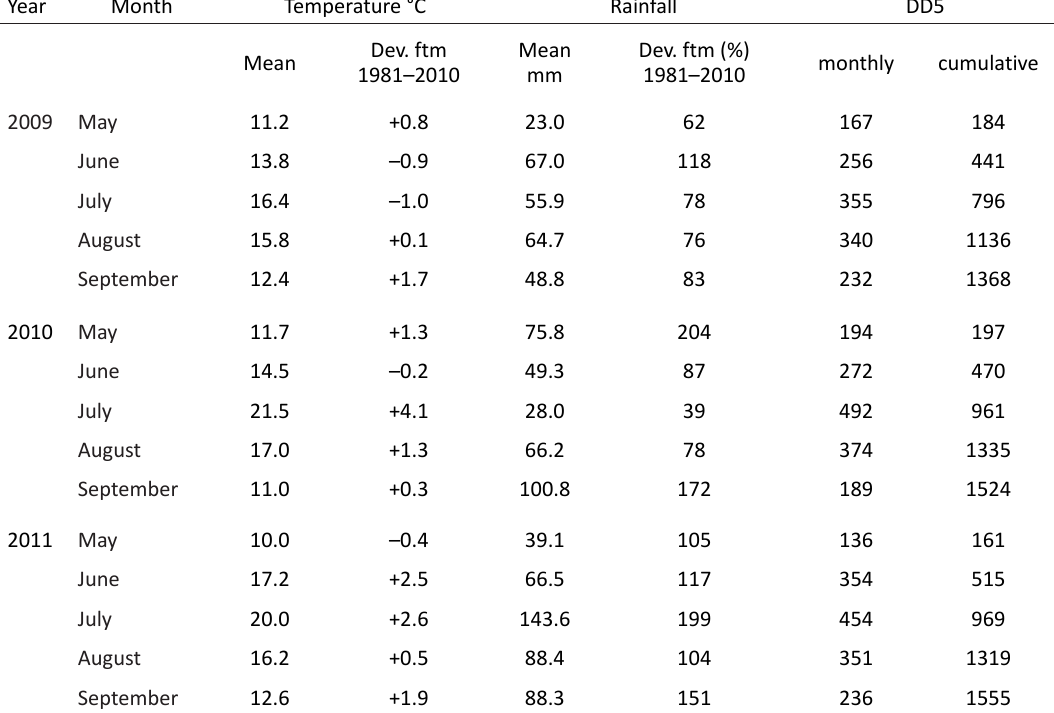
Table 2. Main weather indicators between May and September of 2009, 2010 and 2011. Data on temperature and rainfall, and deviation from their means (dev. ftm) of 1981–2010 measured in Salo, location 60°37’N 23°11’E (Finnish Meteorological Institute 2014). Monthly and cumulative base temperatures during growing season (DD5) collected in Kaarina, Yltöinen, location 60°39’N 22°55’E (Luke